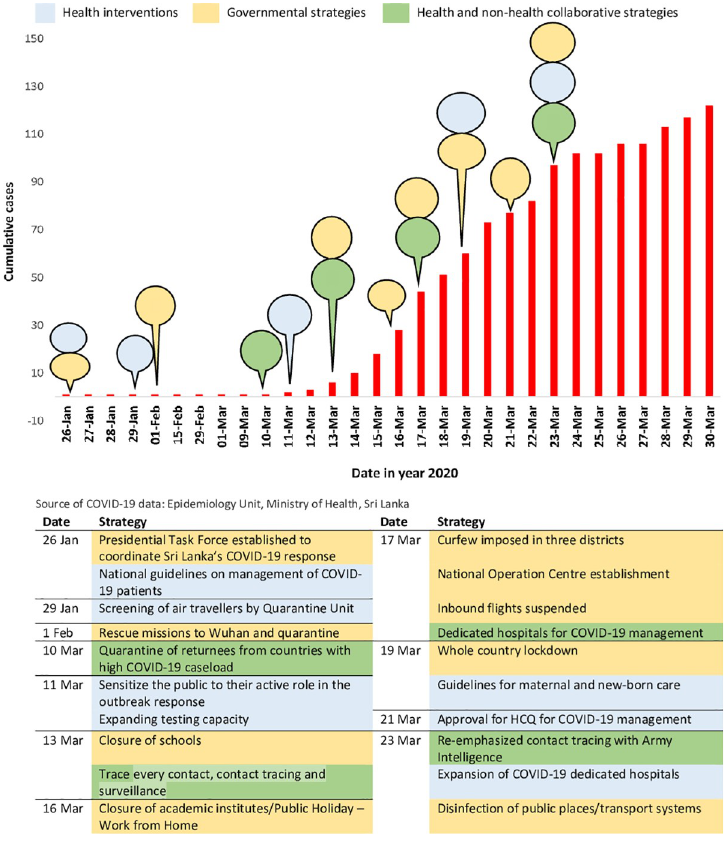
Fig 1. Chronology of the cumulative number of cases and key interventions during the initial phase of COVID-19 in Sri Lanka.